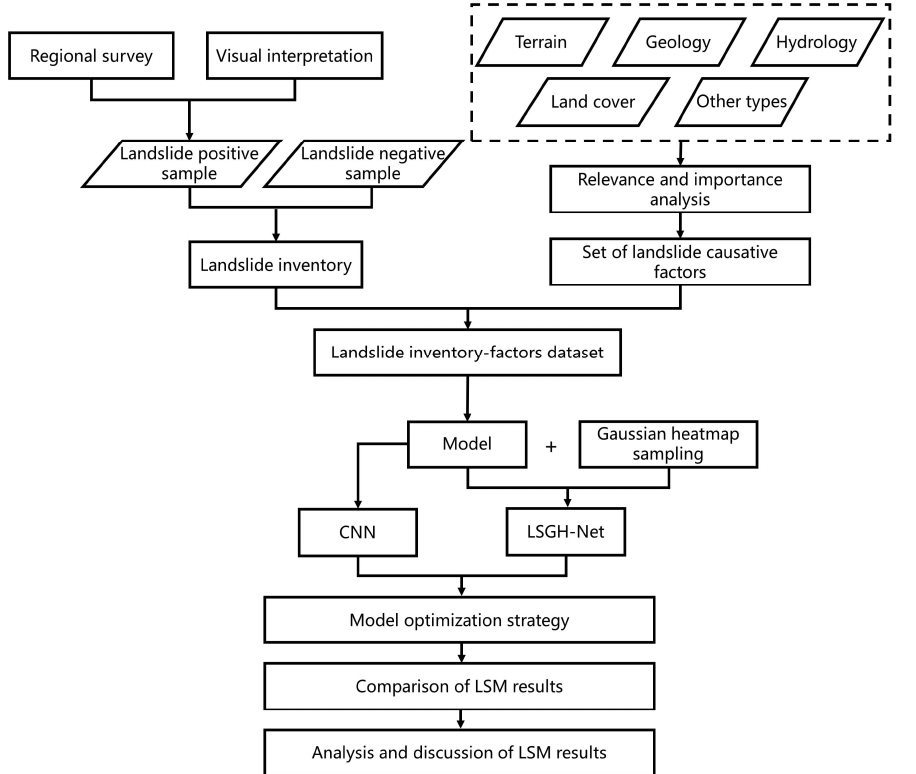
Figure 1. The technical route of this study.